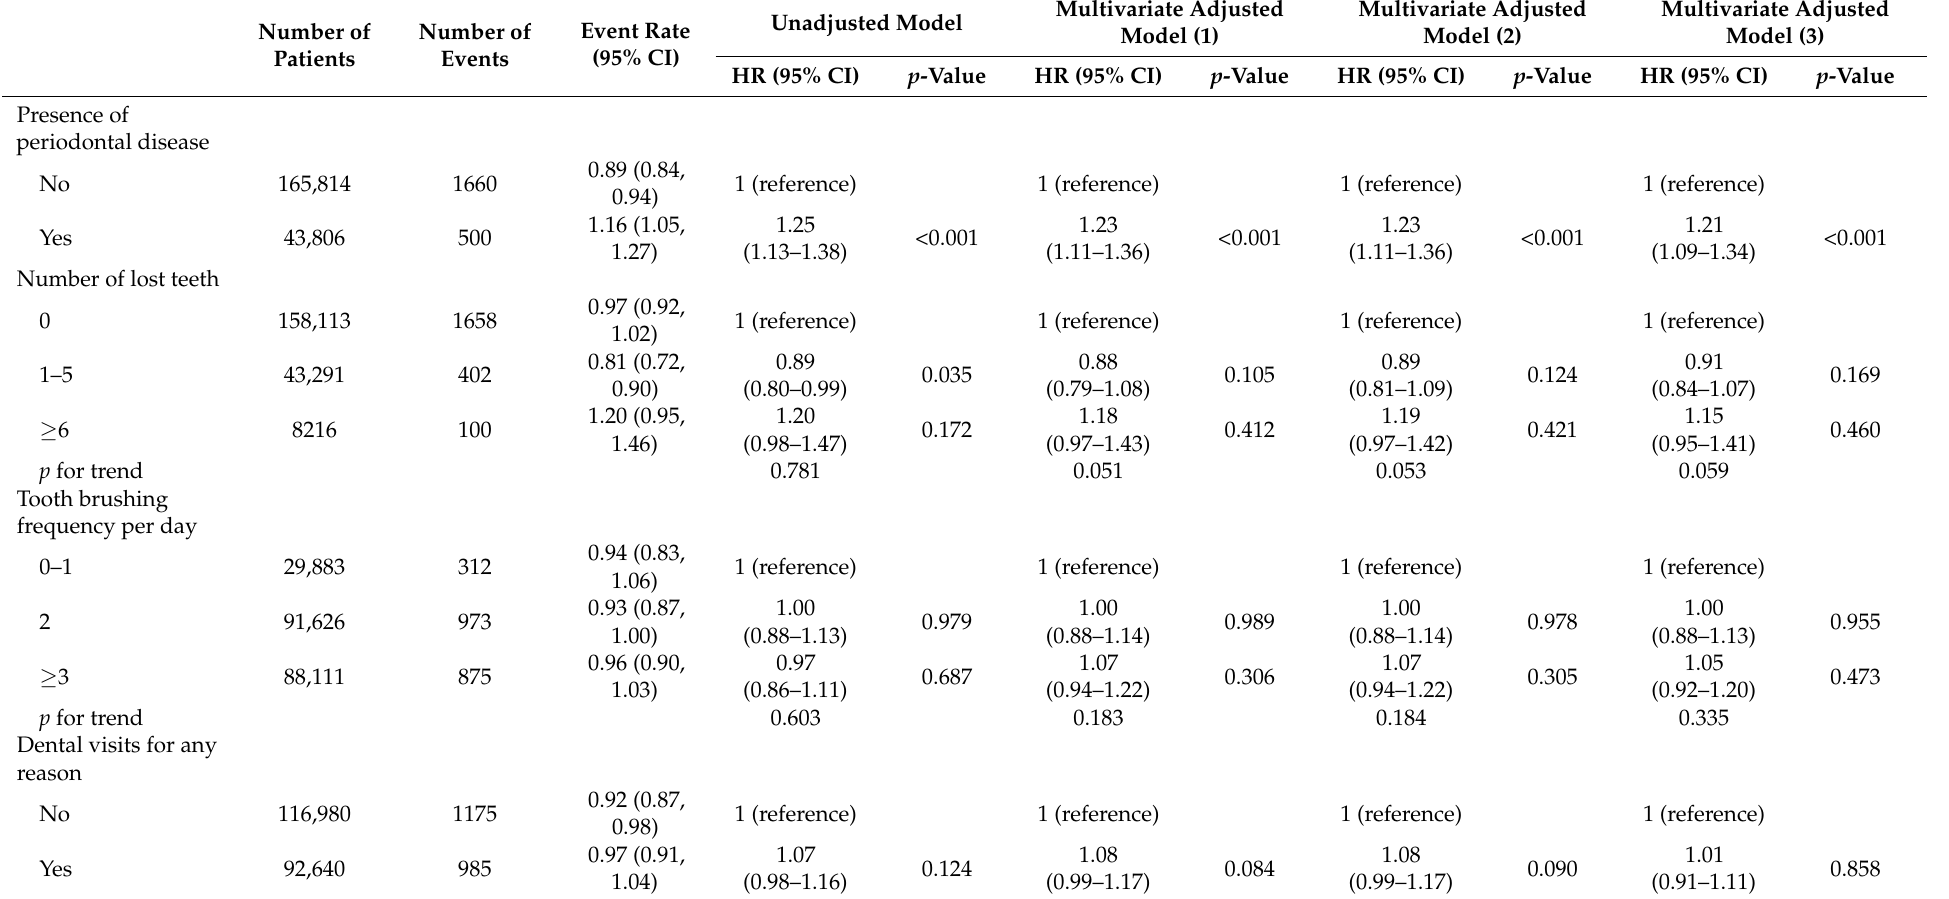
Table 2. Risks of cerebral aneurysms associated with oral hygiene